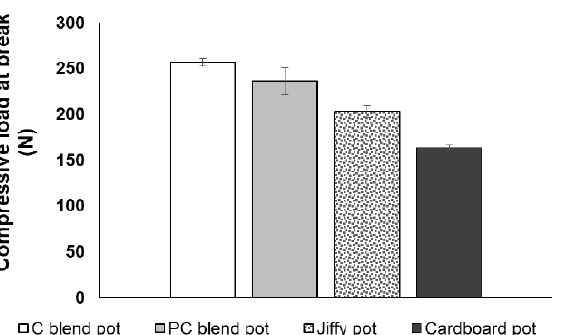
Figure 11. Tensile strength of the developed seedling pots and the commercial pots.